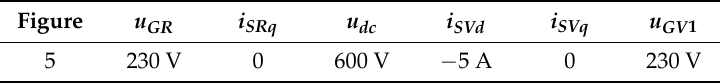
Table 2. Operation conditions of Figure